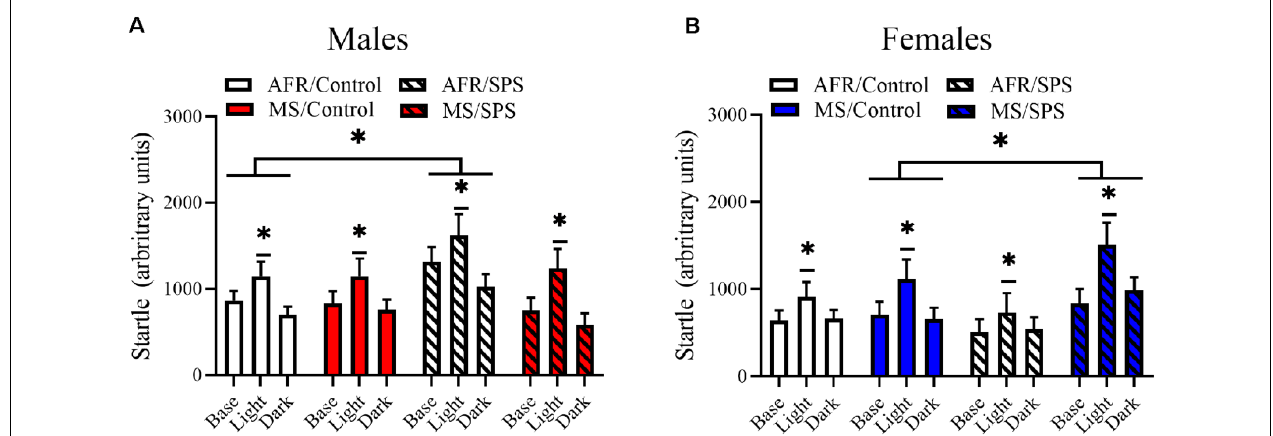
FIGURE 2 | The effects of MS and SPS on startle reactivity. All rats showed light-enhanced startle. (A) Male rats (AFR/control = 17, AFR/SPS = 8, MS/control = 8, MS/SPS = 10) from the AFR group showed enhanced startle reactivity after SPS exposure and this effect was absent in male SPS rats that were subjected to MS as neonates. (B) Female rats (AFR/control = 18, AFR/SPS = 10, MS/control = 10, MS/SPS = 8) from the AFR treatment did not show enhanced startle reactivity to SPS, but females rats from the MS group showed enhanced startle reactivity after exposure to SPS. ∗ Significant statistical test at p < 0.05.